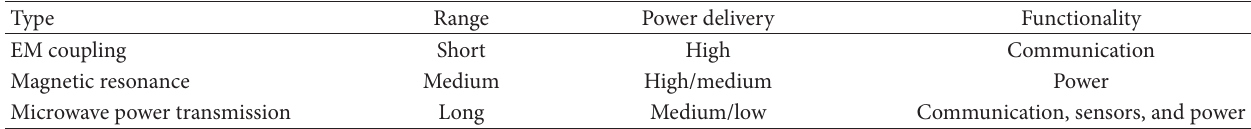
Table 1: WPT classifications by principle.